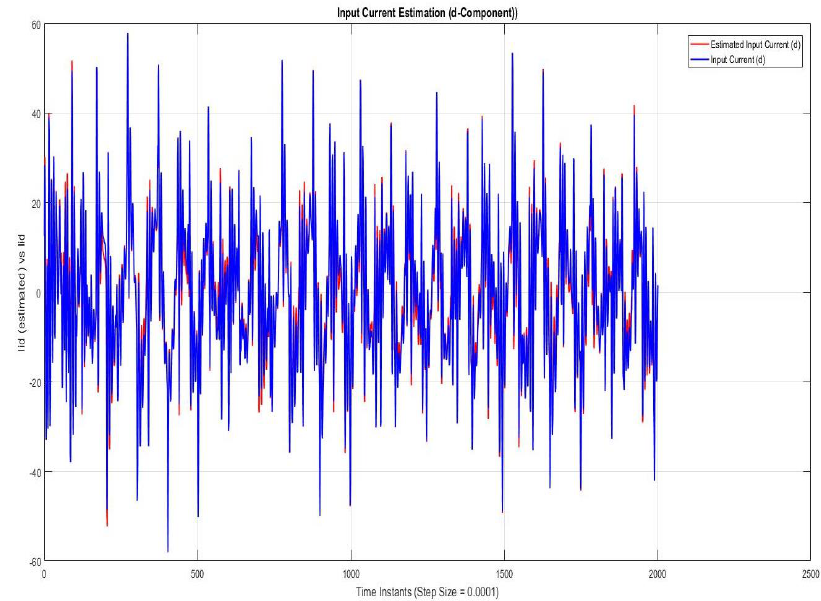
Figure 4. Fault diagnostic observer based input current estimation (d-component).